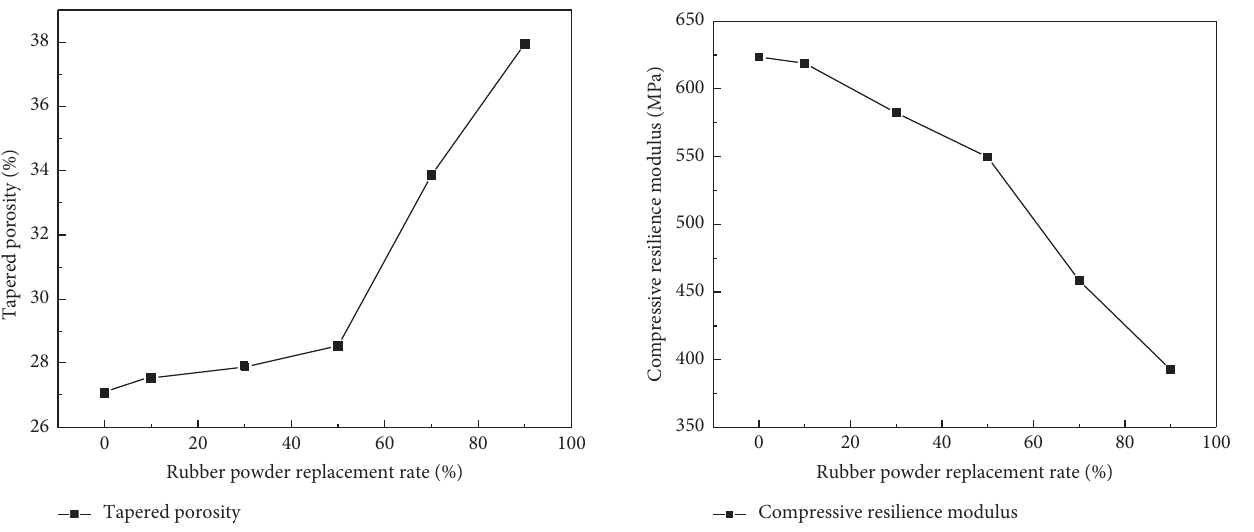
Figure 2: Relationship between rubber powder replacement rate Figure 3: Relationship between rubber powder replacement rate and tapped porosity of mixture. and compressive resilience modulus of mixture. Table 3: Secant slope variation. Tapped porosity secant Rubber powder replacement rate (%)